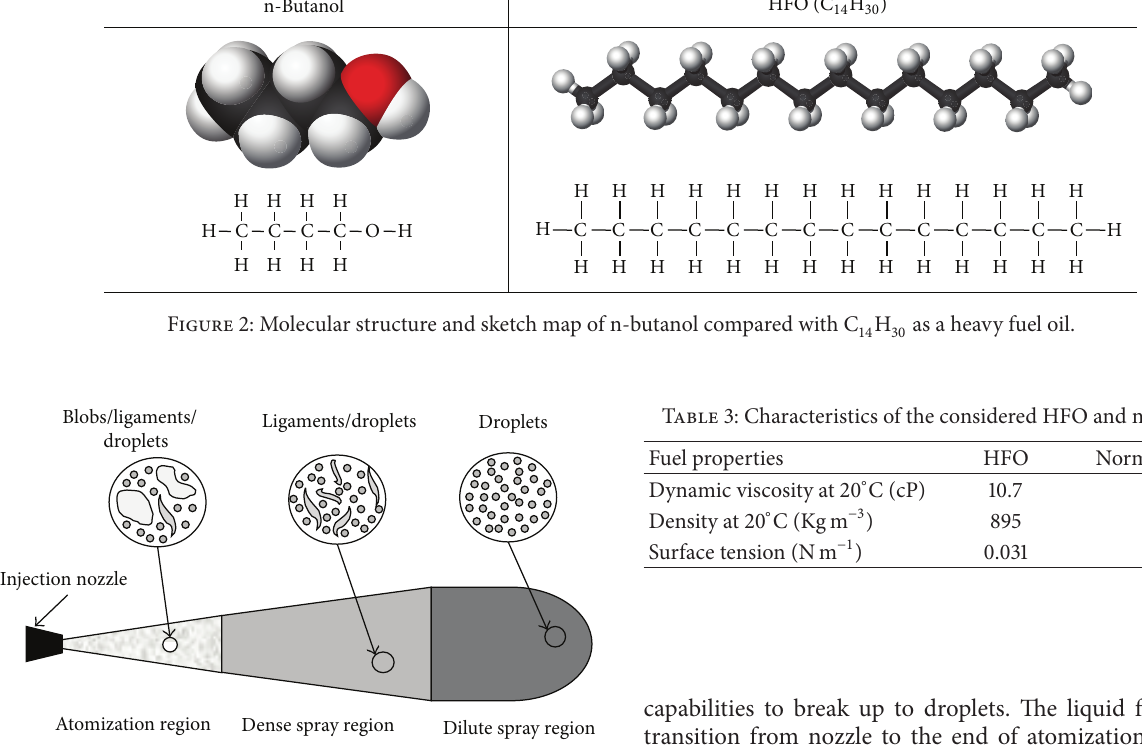
Figure 3: Schematic of liquid spray [22].